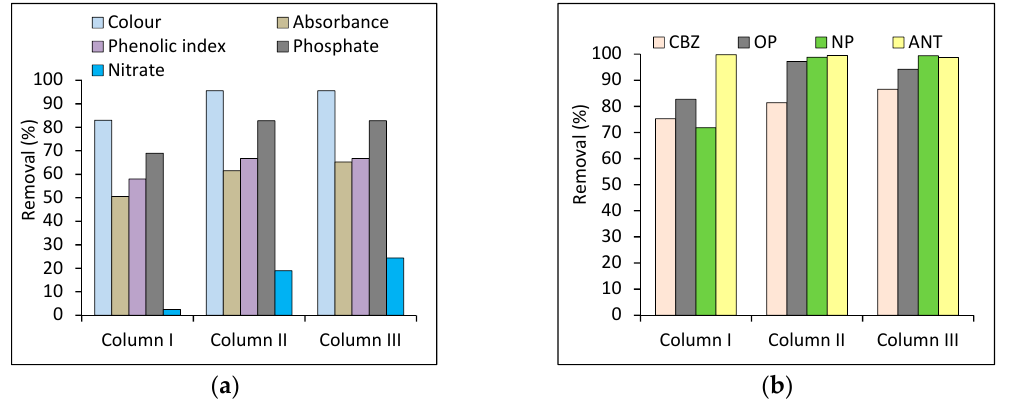
Figure 5. Impact of column filling on treatment of wastewater: ( a ) basic quality parameters; ( b ) micropollutants.